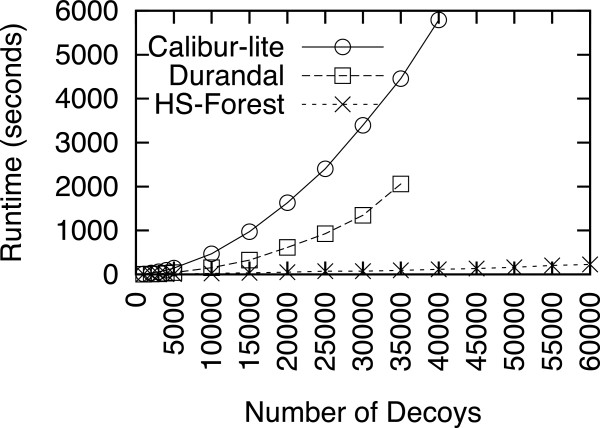
Runtime on the 1bm8 Rosetta decoy set. The size varies from 1,000 to 60,000 structures. Durandal runs out of memory when the size exceeds 40,000 proteins. Calibur-lite takes more than 2 hours to finish a run when the number of proteins was more than 45,000.